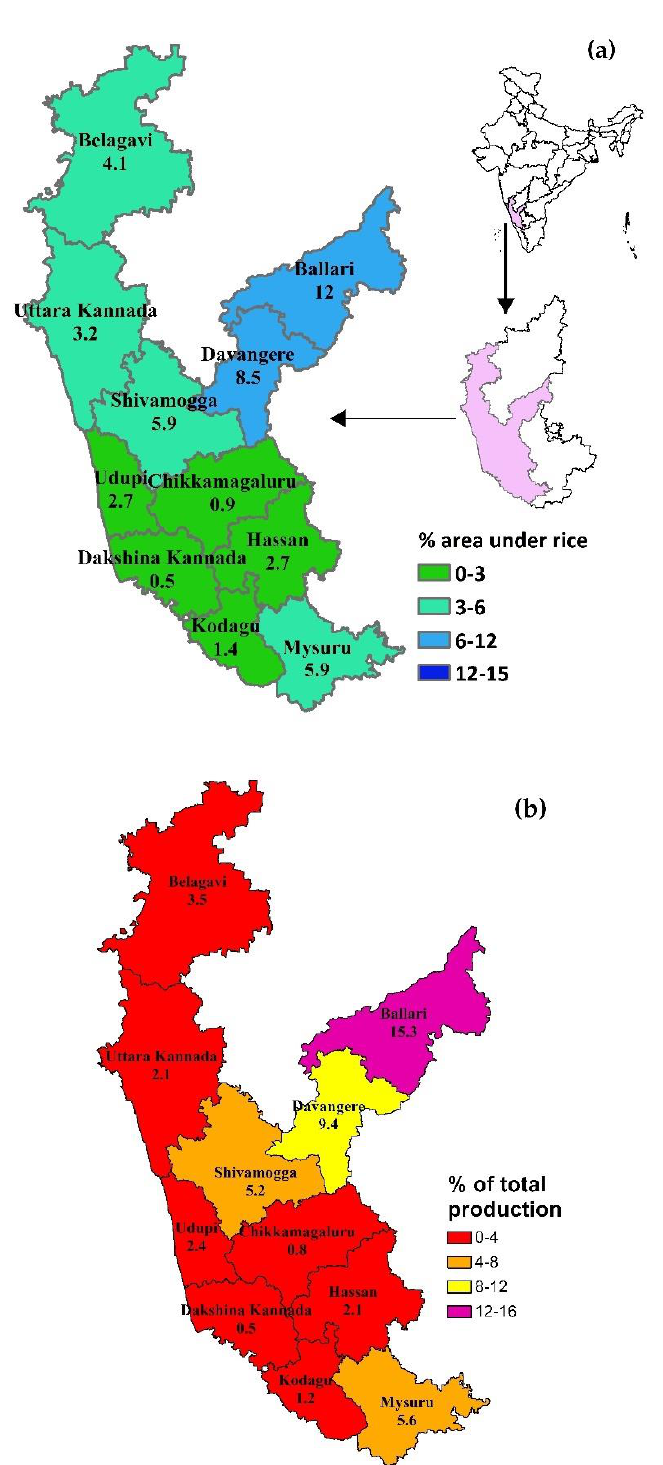
Figure 1. Percentage of rice area ( a ) and percent contribution to state’s rice production ( b ) by each district of the study area (Source: Rice area and production (2021), Directorate of Economics and Statistics, GoK).